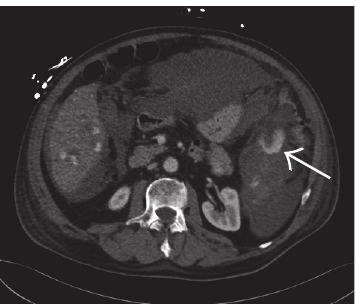
Figure 4: Venous phase: extravasation of contrast agent suggesting perisplenic bleeding (white